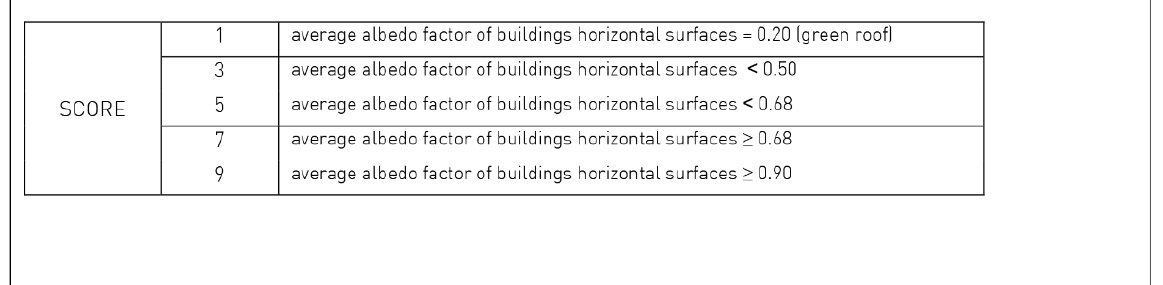
Figure A11. Descriptive sheet of the indicator of “Average albedo of building roofs”.